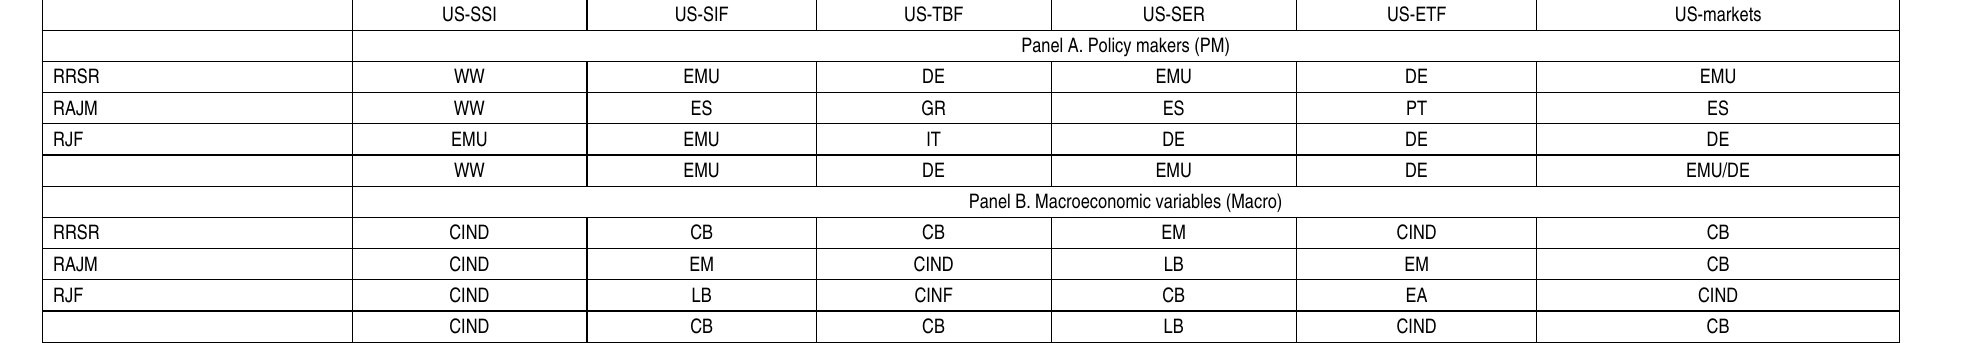
Table 15. Summarized results - US financial